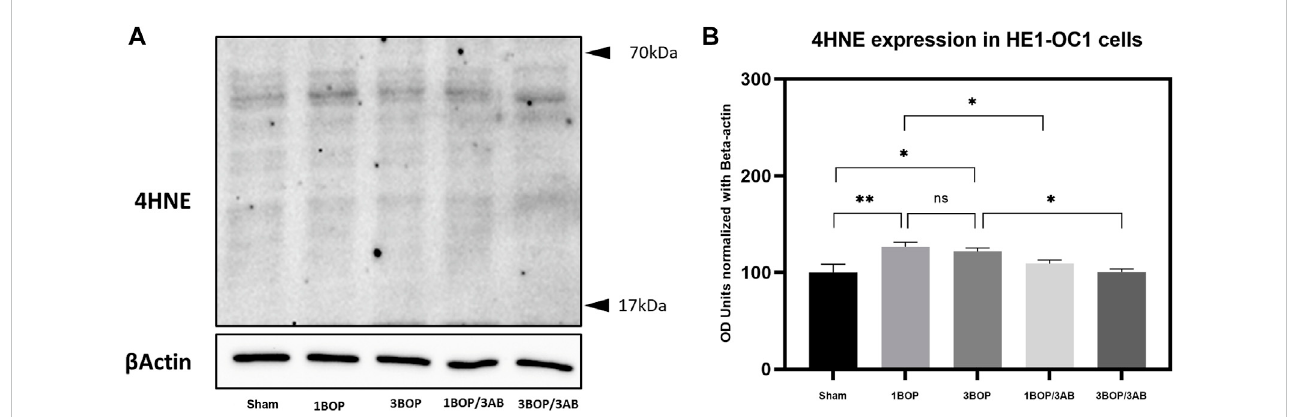
FIGURE 8 Assessment of 4HNE protein expressions by immunoblotting analysis in HEI-0C1 after BOP exposure. The (A) immunoblots shows the protein expressions of 4HNE levels in HEI-OC1 cells. (B) The histogram shows the semi-quantitative protein expression of 4HNE levels in HEI-OC1 cells normalized against the internal control 13-Actin. Statistical difference between the cell groups were (* p < 0.0S; ** p < 0.005) represented as Mean ± SEM ( n = 3).